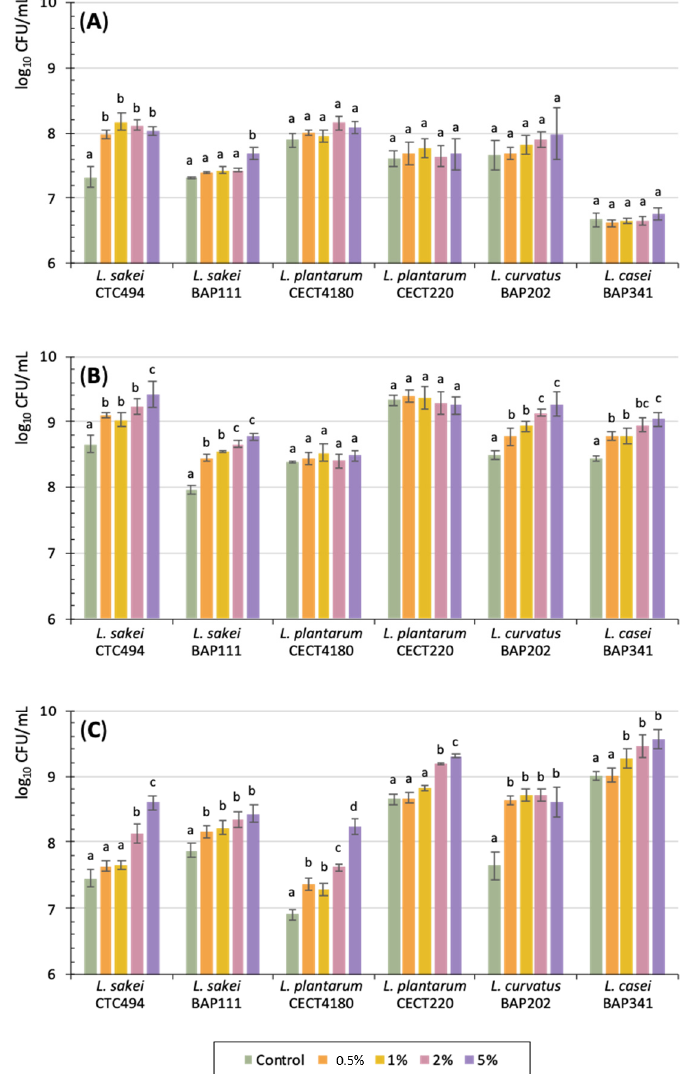
Figure 2. Concentration of 6 LAB strains in growth media without (control) and with different amounts of cava lees after 6 h ( A ), 24 h ( B ), and 48 h ( C ) of incubation. The average and standard deviation (bars) of three independent experiments are displayed. Different letters denote statistically significant differences ( p < 0.05) between amounts of added cava